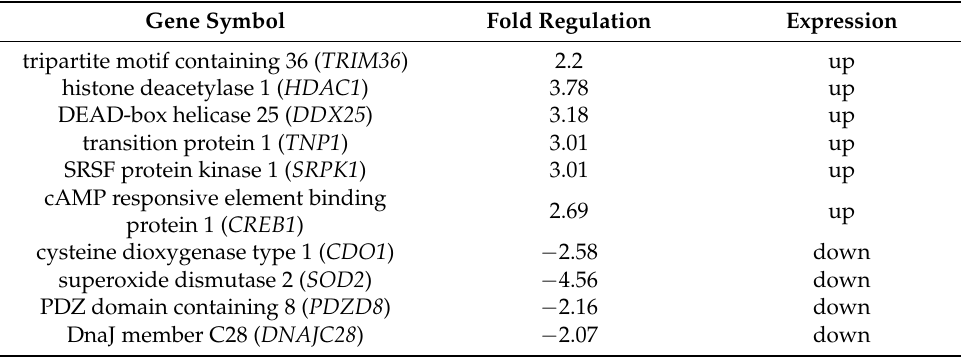
Figure 5. The effect of the AXL gene on male reproductive function genes. ( A ) The relative abundance of the transcript of AXL in Sertoli cells. ( B ) The relative abundance of the transcript of 10 male reproduction-related genes. Data were presented as means ± SEM. Standard Error of Mean (SEM) was indicated by error bars. p < 0.05 was considered to be statistically significant. **** p < 0.0001. Table 3. Differently expressed genes related to male